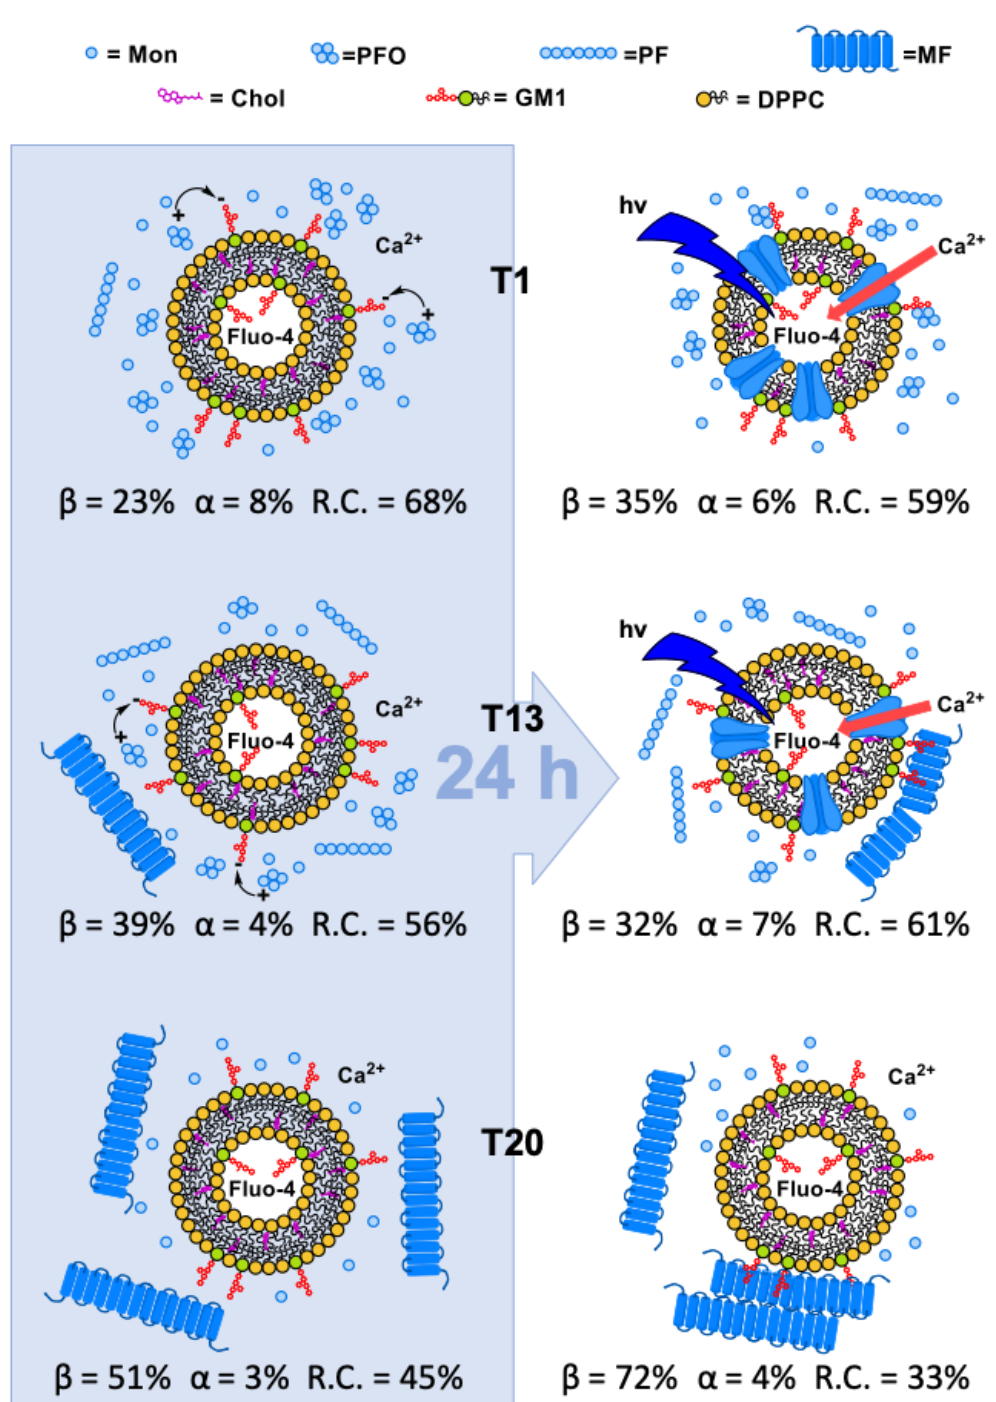
Figure 12. Graphical sketch summarizing the interpretation of the all body of our experimental